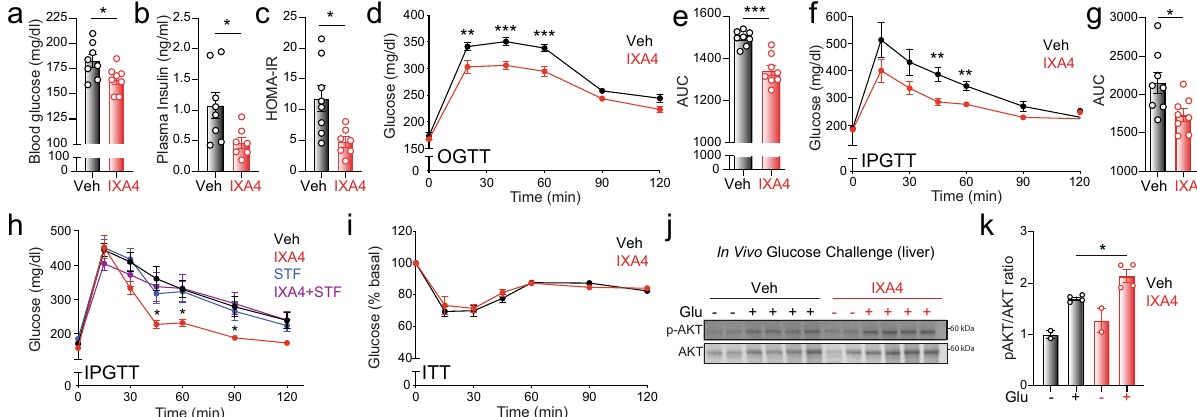
Fig. 2 Chronic IXA4 treatment enhances systemic glucose homeostasis. a – c Fasted plasma glucose ( a ), insulin ( b ), and HOMA-IR ( c ) in DIO mice after 46 days of IXA4 treatment. Error bars show SEM for n = 7 or 8 mice. One IXA4-treated mouse was excluded from panels b , c using a ROUT outlier test. * P < 0.05 for a two-tailed Welch ’ s t test. d Oral GTT in DIO mice 38 days after start of IXA4 treatment. Error bars show SEM for n = 8 mice/condition. ** P < 0.01, *** P < 0.001 for two-way ANOVA. e Area under the curve (AUC) quanti fi cation of the OGTT in ( d ). *** P < 0.001 for a two-tailed Welch ’ s t test. f Intraperitoneal GTT (IPGTT) in DIO mice 22 days after start of IXA4 treatment. Error bars show SEM for n = 8 mice/condition. ** P < 0.01 for a two-tailed Welch ’ s t test. g AUC quanti fi cation of the IPGTT in ( f ). * P < 0.05 for a two-tailed Welch ’ s t test. h IPGTT in DIO mice 10 days after start of treatment with IXA4 (50 mg/kg) and/or STF-083010 (STF; 5 mg/kg). Error bars show SEM for n = 8 mice/condition. * P < 0.05 for two-way ANOVA comparing mice treated with IXA4 in the presence or absence of STF. i ITT in DIO mice after 17 days of IXA4 treatment. Error bars show SEM for n = 8 mice/condition. j Immunoblot of AKT phosphorylation in liver 15 min after an oral bolus of glucose was administered to DIO mice treated for 60 days with IXA4. k pAKT/ AKT ratio of immunoblots shown in ( j ). Error bars show SEM for n = 2 or 4 replicates, * P < 0.05 for a two-tailed Welch ’ s t test. Source data for all panels in this fi gure are provided as Source Data File 2. Uncropped images of the immunoblots in panel ( j ) are included in Source Data.